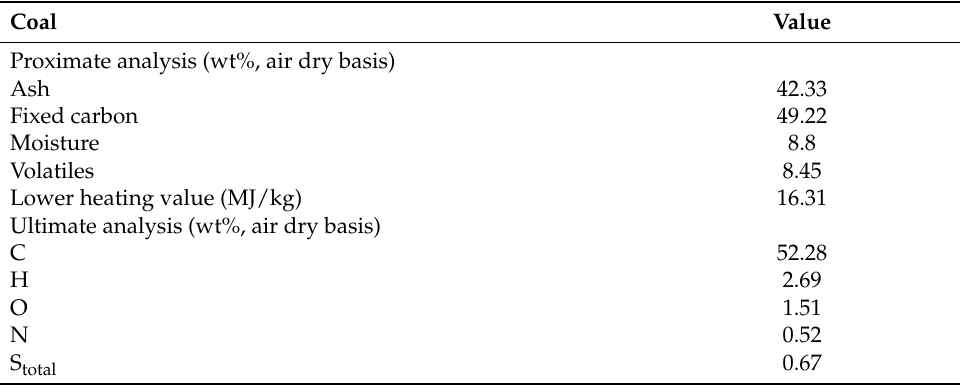
Table 5. Proximate and ultimate analysis of the feeding coal during the